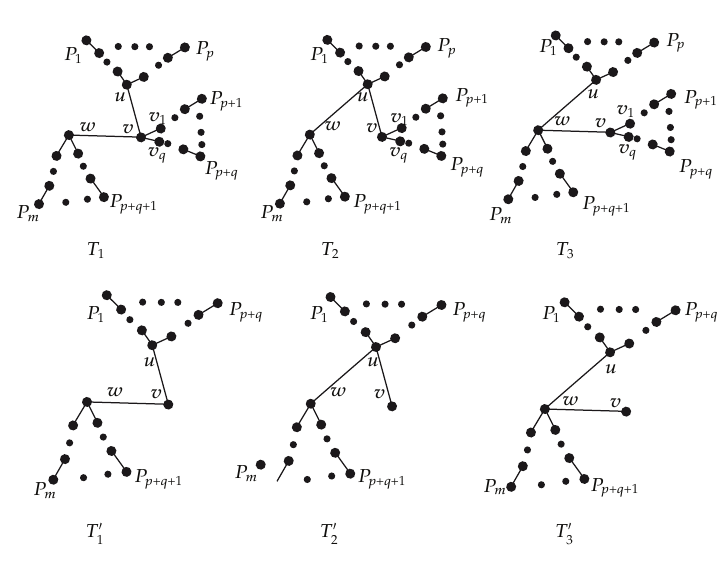
Figure 5: Obtained trees from Figure